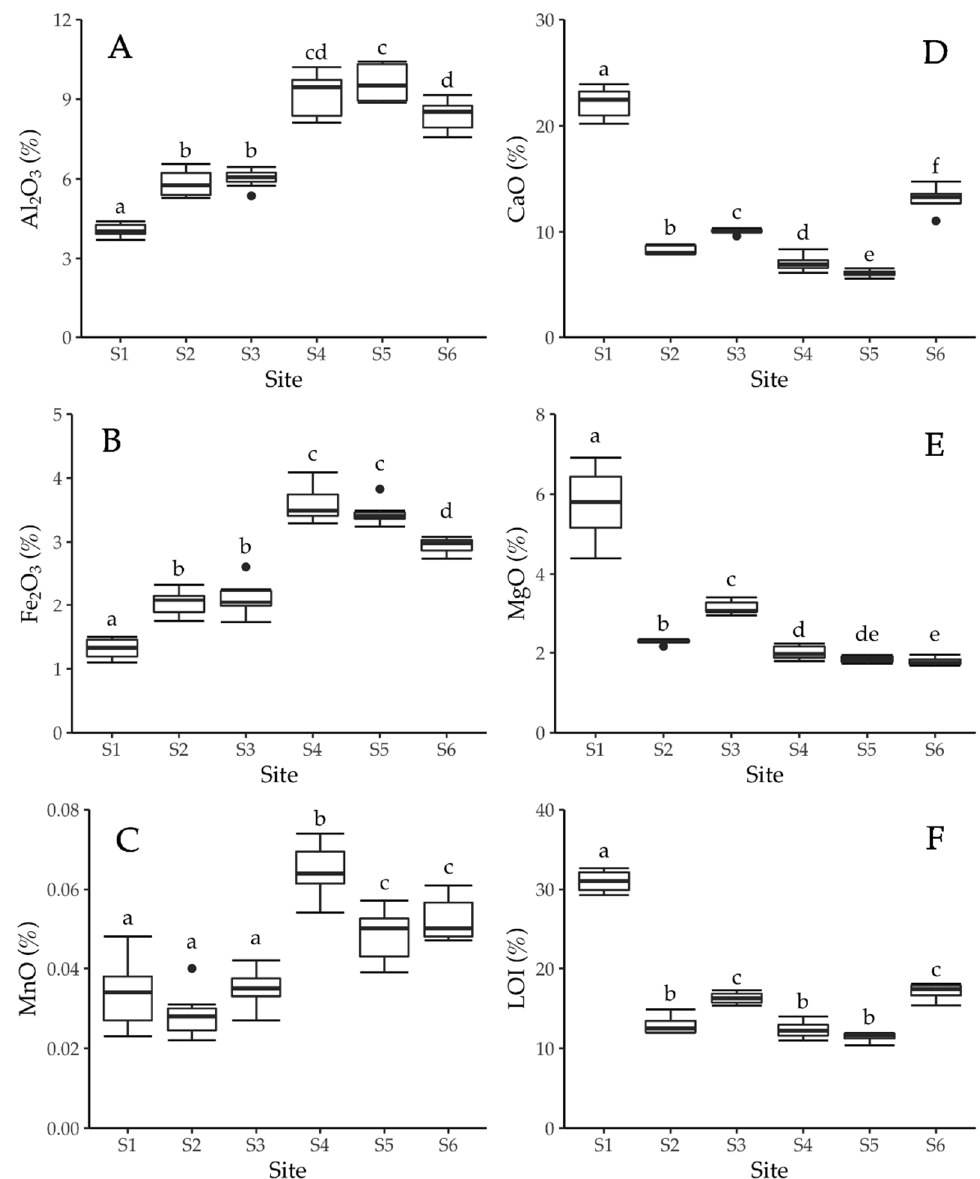
Figure 3. ( A ) Al 2 O 3 , ( B ) Fe 2 O 3 , ( C ) MnO, ( D ) CaO, ( E ) MgO, and ( F ) LOI composition (percent by mass) of interstitial fine sediment stored in the gravel-bed of the Crowsnest River in 2016 and 2017 ( n = 7 per site). The lowercase letters denote statistically significant differences ( α < 0.05). Horizontal lines indicate the median, boxes indicate lower/upper quartiles, error bars indicate 1.5 times the inter-quartile range or the minimum/maximum value observed, whichever is smaller.